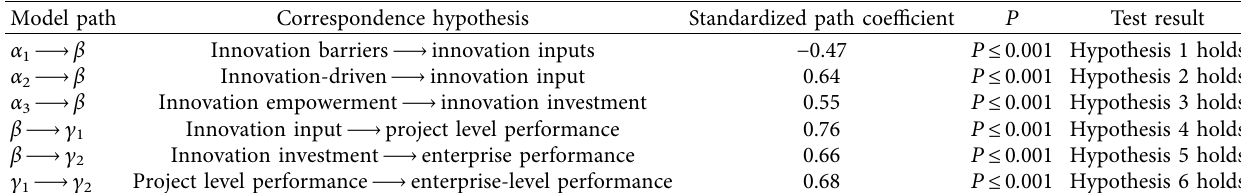
Table 5: Test results of